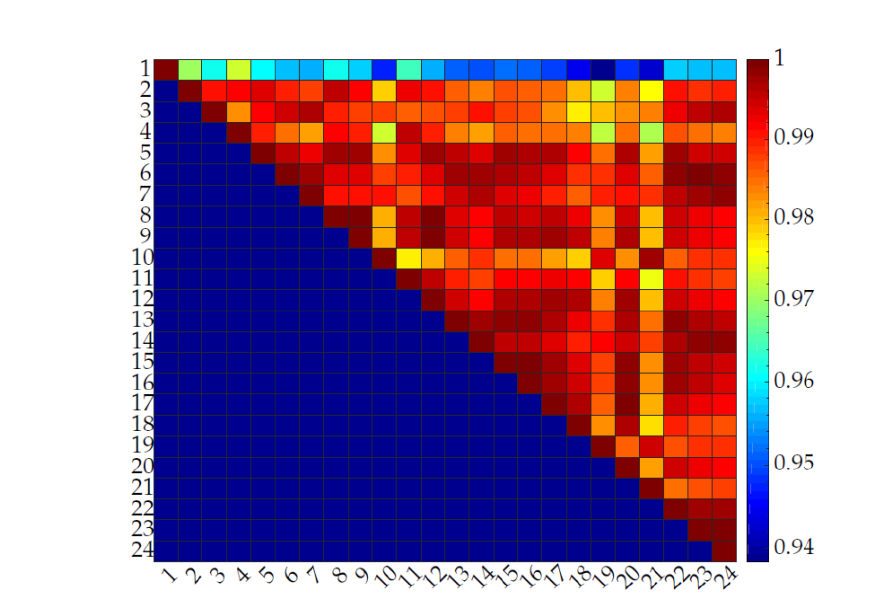
Figure 25. Normalized cross-correlation between sinusoidal motions for a band with a low iteration frequency (5 cycles/min) and high stretch length (14